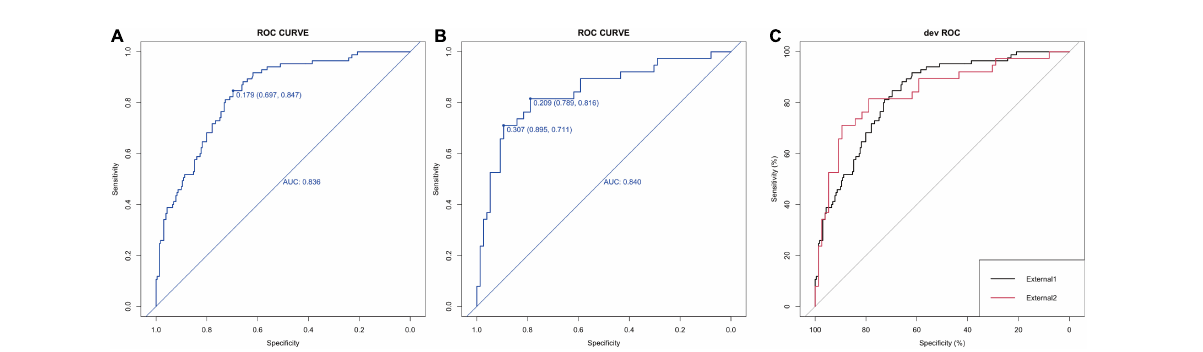
FIGURE4 Calibration and DCA validation for the logistic models for the external datasets. (A,B) ROC curve of the 5-factor logistic model for two external datasets which show the AUC value. (C) The comparison between the ROC curve by the Delong’s test.